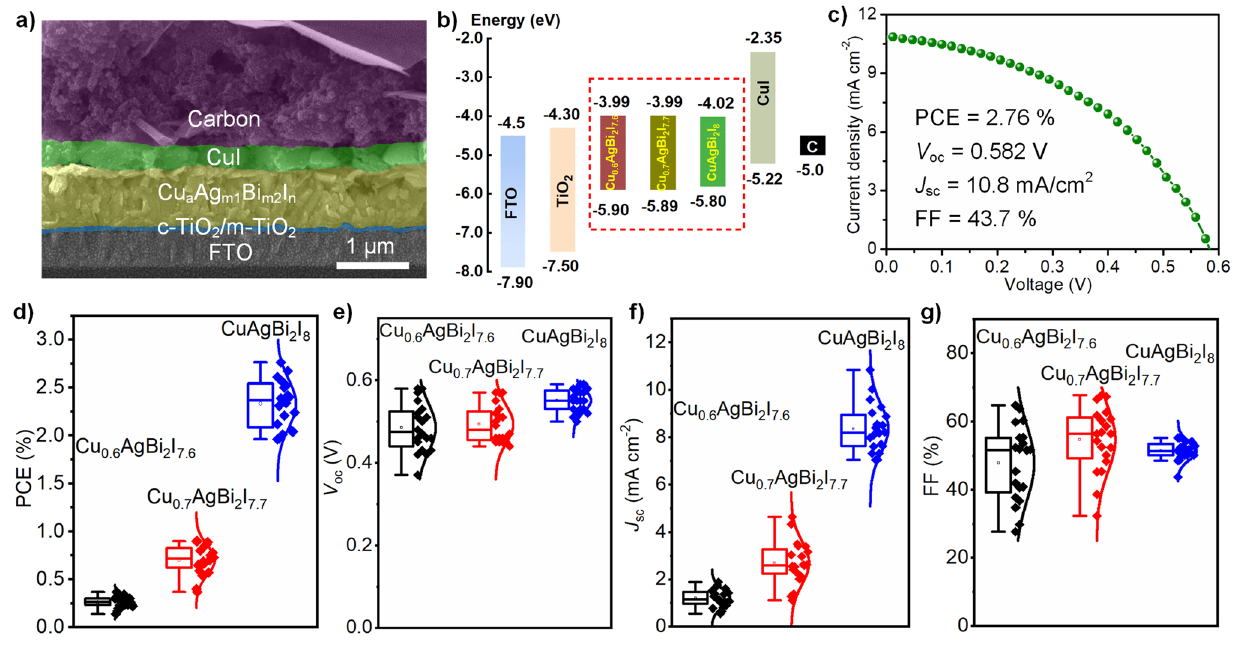
Fig. 4 a Cross-sectional SEM image of the device with the architecture of FTO/c-TiO 2 /m-TiO 2 /Cu a Ag m1 Bi m2 I n /CuI/carbon. b Band alignment diagram of Cu a Ag m1 Bi m2 I n film. c J-V plot of champion CuAgBi 2 I 8 solar cell. The inset shows its J-V parameters PCE, V oc , J sc and FF. d PCE, e V oc , f J sc and g FF statistics of 20 devices under each condition. The box lines indicate the standard deviation, and the central represents the mean